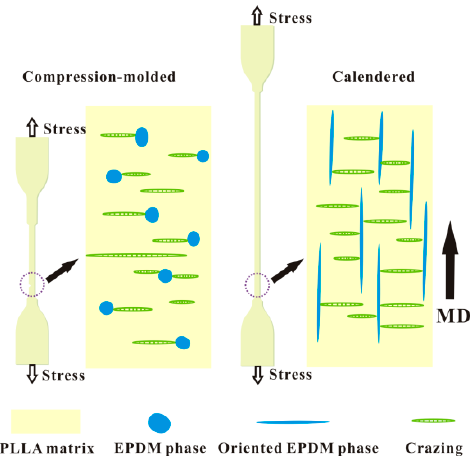
Figure 8. Schematic illustration of craze termination mechanism for PLLA / EPDM / OMMT (90 / 10 / x ) samples prepared by compression-molding and calendering.